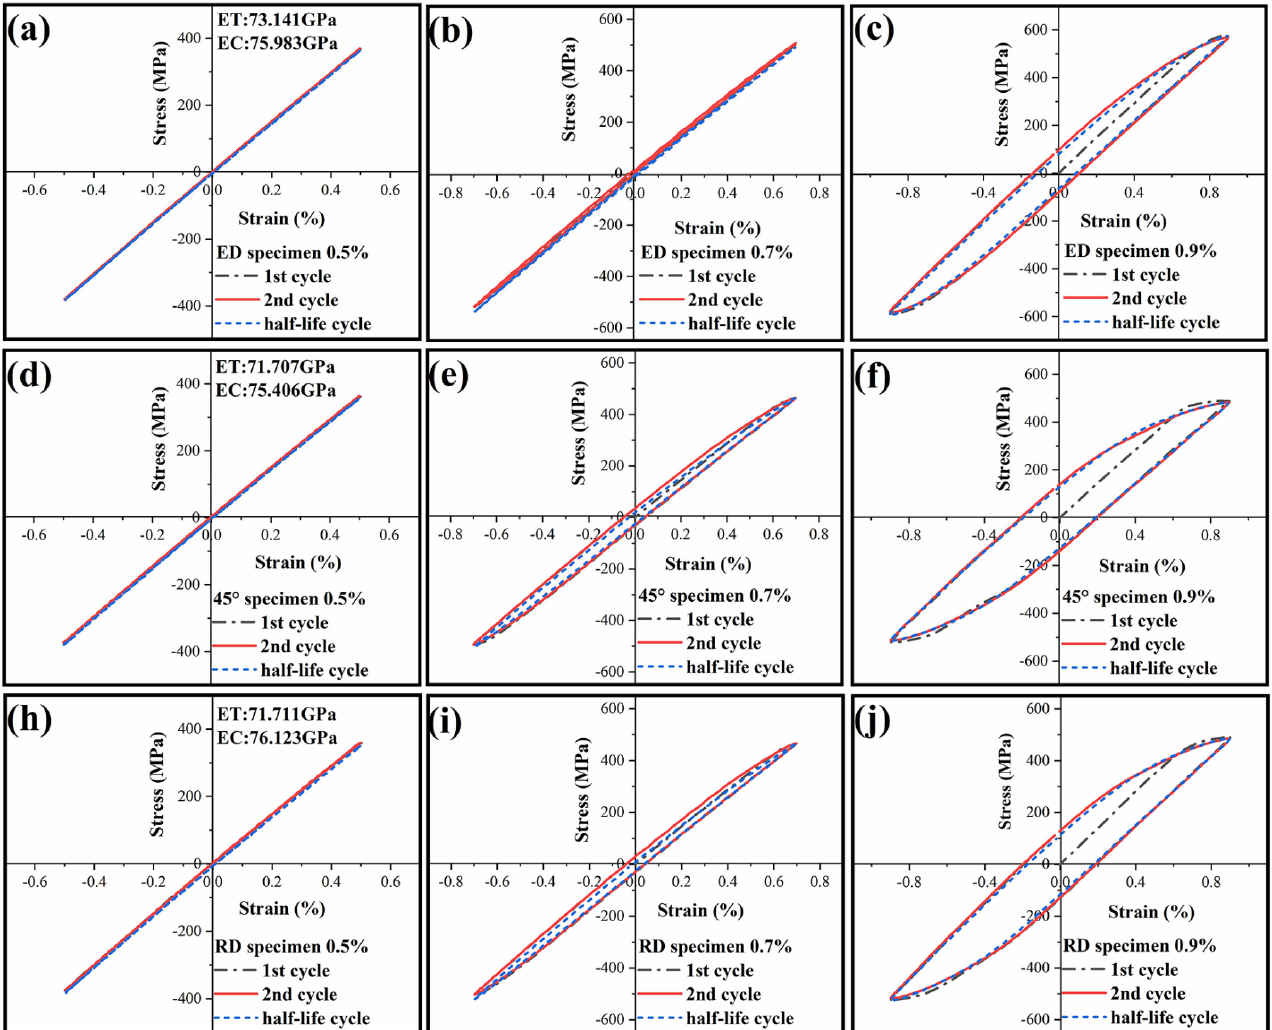
Figure 9. The evolutionary change of stress-strain hysteresis loops for the ED ( a – c ),45° ( d – f ) and RD ( h – j ) specimens at different total strain amplitudes of ( a , d , h ) 0.5%, ( b , e , i ) 0.7%, and ( c , f , j ) 0.9%.